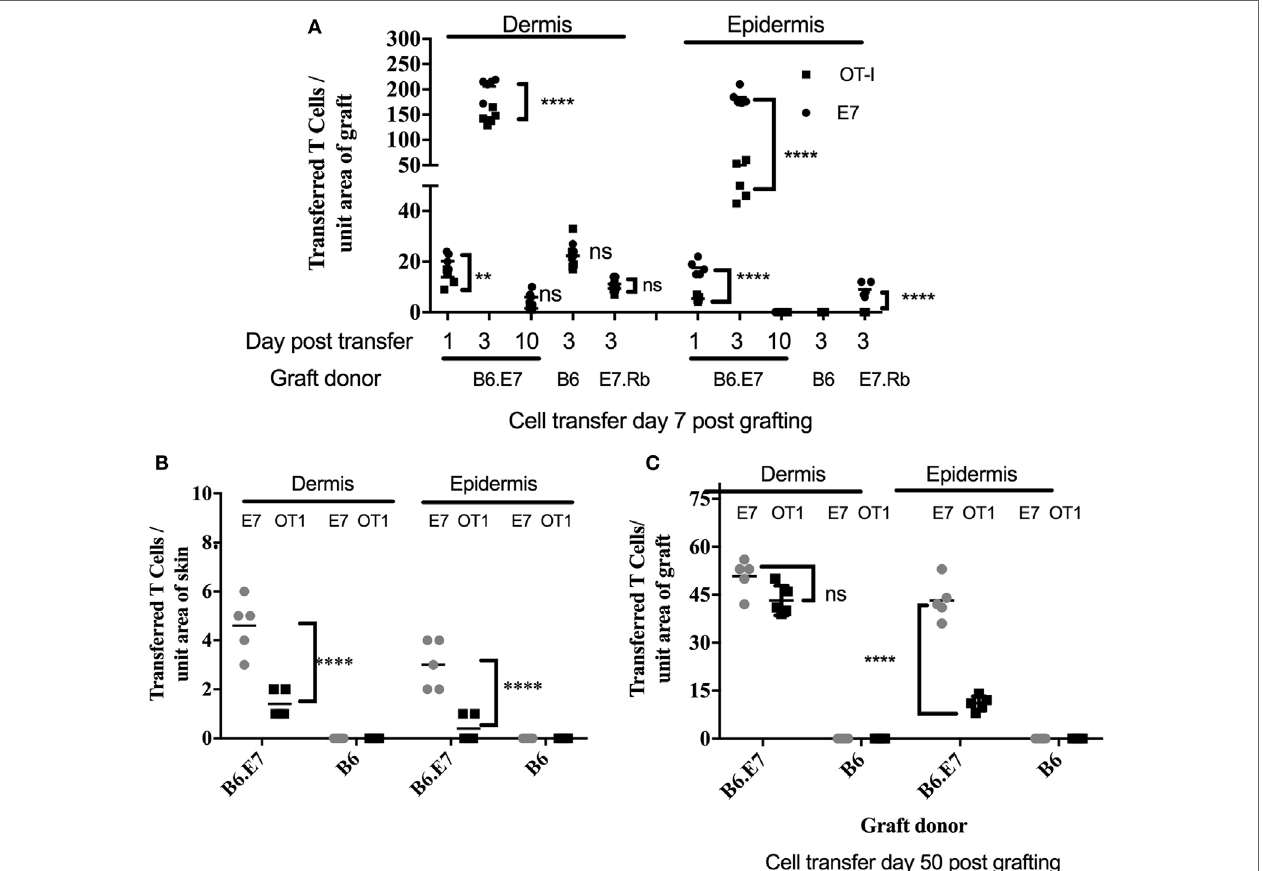
FigUre 3 | Preferential migration of e7-specific cD8 T cells to the epidermis of hyperproliferative epithelial grafts and ear skin . B6 mice received grafts of ear skin from B6, B6.K14.E7 (B6.E7), or B6.K14E7.Rb mut/mut (E7.Rb) mice as shown. After 7 or 50 days, graft recipients received 2.5 × 10 6 in vitro activated E7TCR269 (E7) and OT-1 CD8 T cells by i.v. injection, prepared and labeled as in Figure 2 . At various time points after cell transfer, grafted (a,c) or donor ear (B) skin was harvested, frozen sections prepared, and the number of E7 and OT-1 cells enumerated in epidermis and dermis. (a) Transferred T cell numbers in B6, B6.E7, and E7.Rb grafts on B6 mice after cell transfer performed day 7 post grafting. (B) Transferred T cell numbers in ear skin of B6 and B6.E7 mice 3 days after cell transfer. (c) Transferred T cell numbers in B6 and B6.E7 grafts on B6 mice 3 days after cell transfer performed at day 50 post grafting. Data averaged over 35 areas of five independent grafting experiments are shown (**** p < 0001, ** p < 0.01; unpaired t